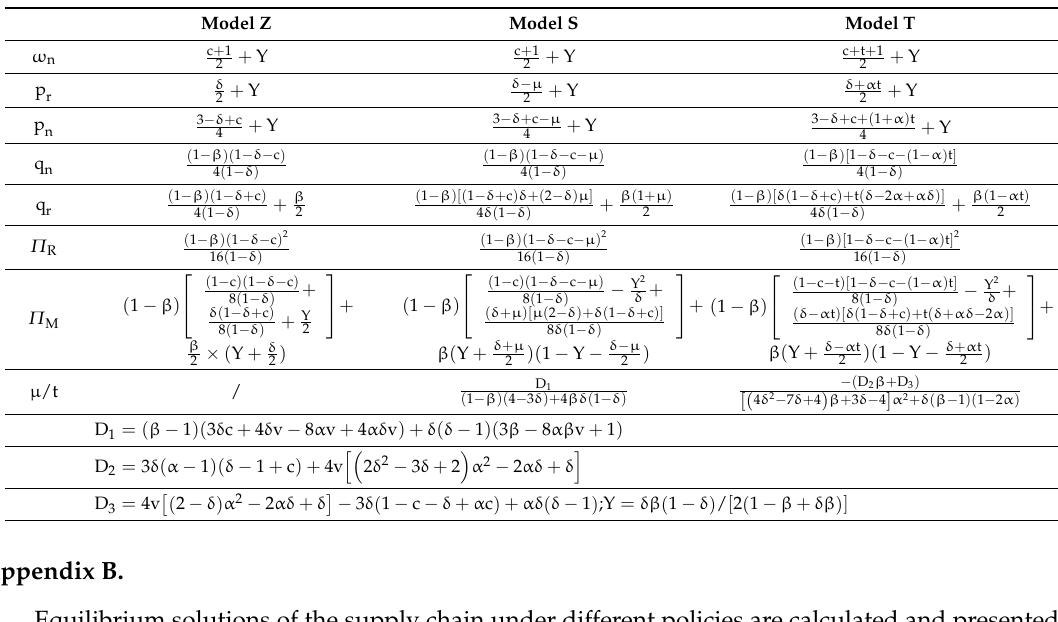
Table A1. Comparison of the optimal decisions under different